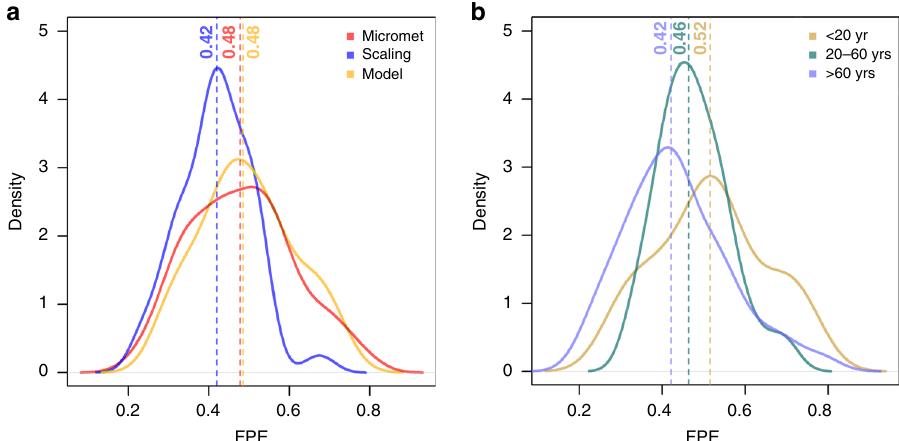
Fig. 2 Effects of GPP method and age on FPE variability. a Forest production ef fi ciency (FPE) density plots for three subsets of data where the GPP was estimated with three different methods (micrometeorological, red line, n = 98; scaling, blue line, n = 73; and models, green line, n = 53). The vertical lines are medians. b Density plots for different age classes (age < 20 years, light brown line, n = 47; 20 – 60 years, green line, n = 49; and age > 60 years, blue line, n = 77).